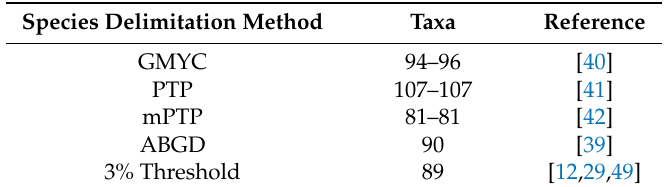
Table 1. Species delimitation. Species delimitation from an ultrametric COI sequence tree generated with a Yule or Coalescent model with constant population size was used by the GMYC, PTP and mPTP methods. Species delimitation from ABGD and 3% distance was based on FASTA sequences only. The number of predicted biological entities is shown in the taxa column.